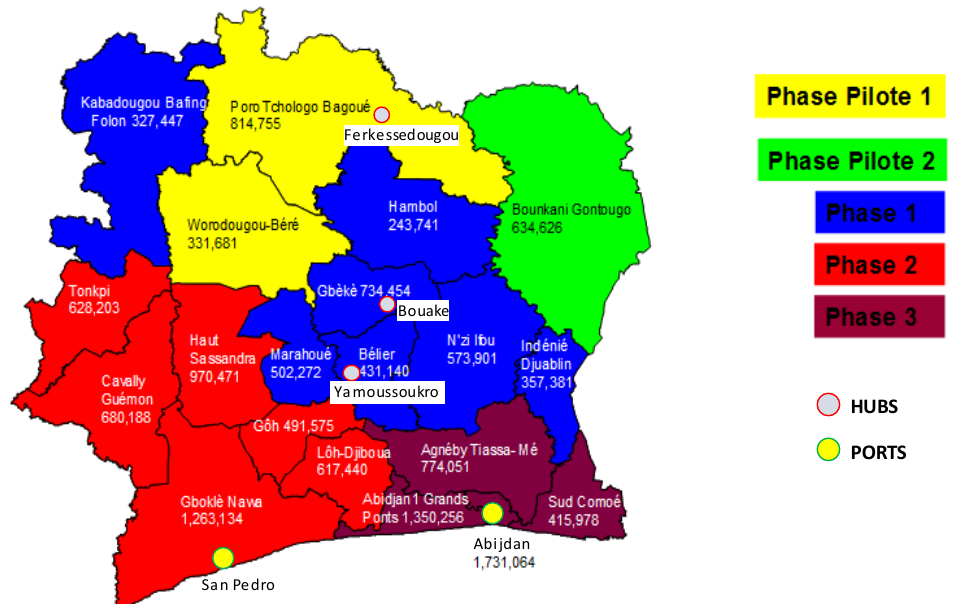
Figure 1. Ivory Coast (CIV) map and phases of long-lasting insecticide-treated nets (LLINs) distribution.